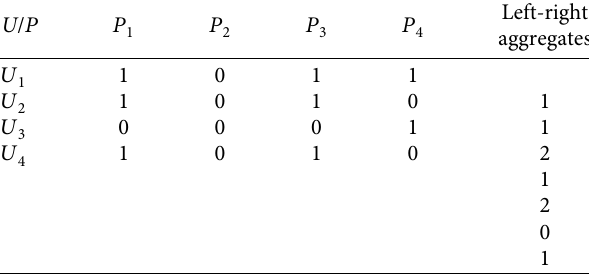
Table 4: Left-right diagonal aggregate set.